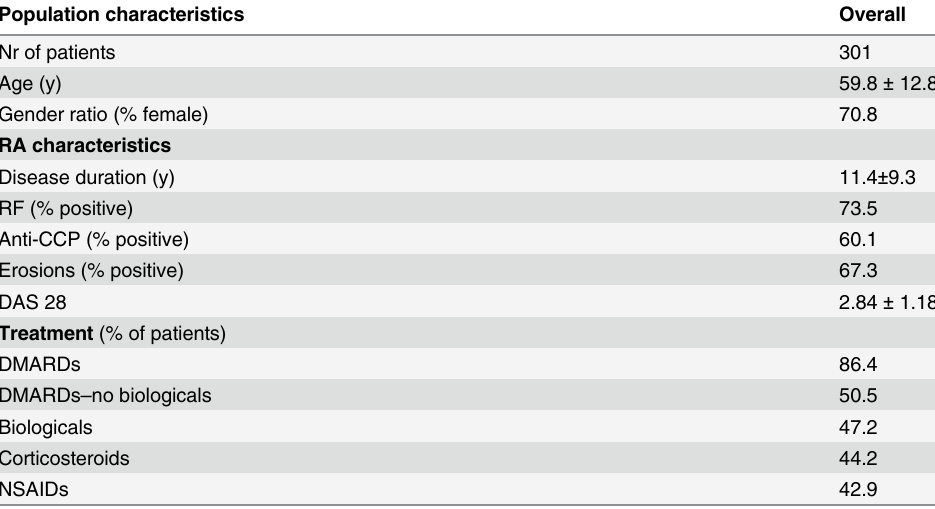
Table 2. Population